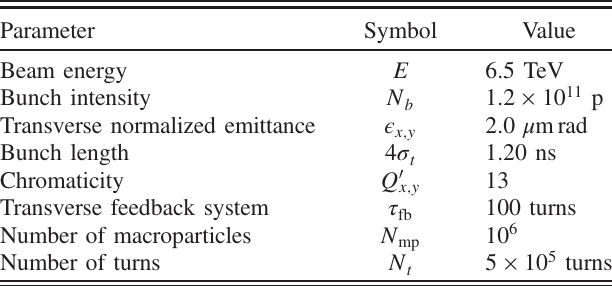
TABLE II. Main parameters used in P y HEADTAIL to reproduce the LHC experimental machine setup at 6.5 TeV.